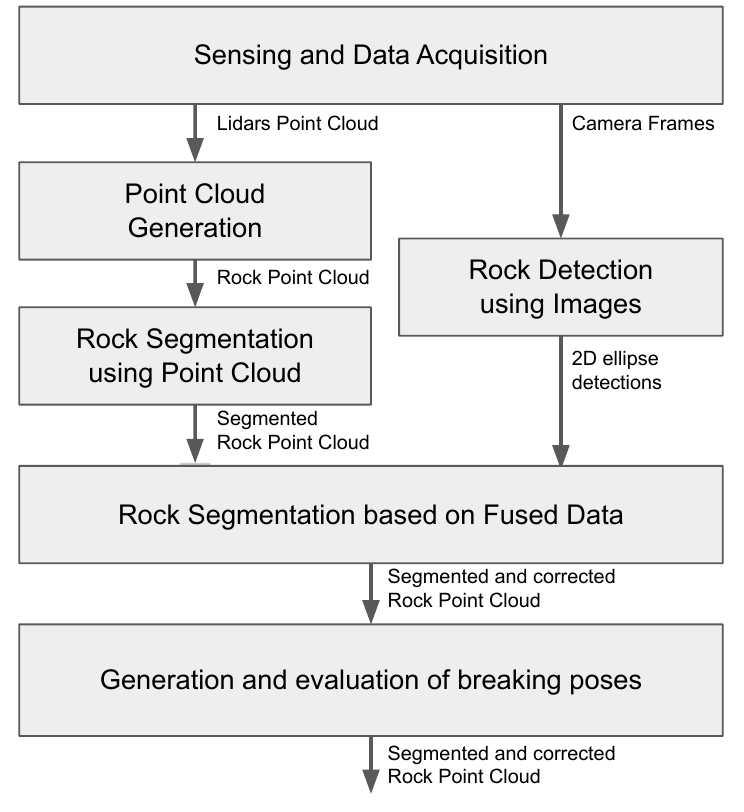
Figure 2. Block diagram of rock segmentation